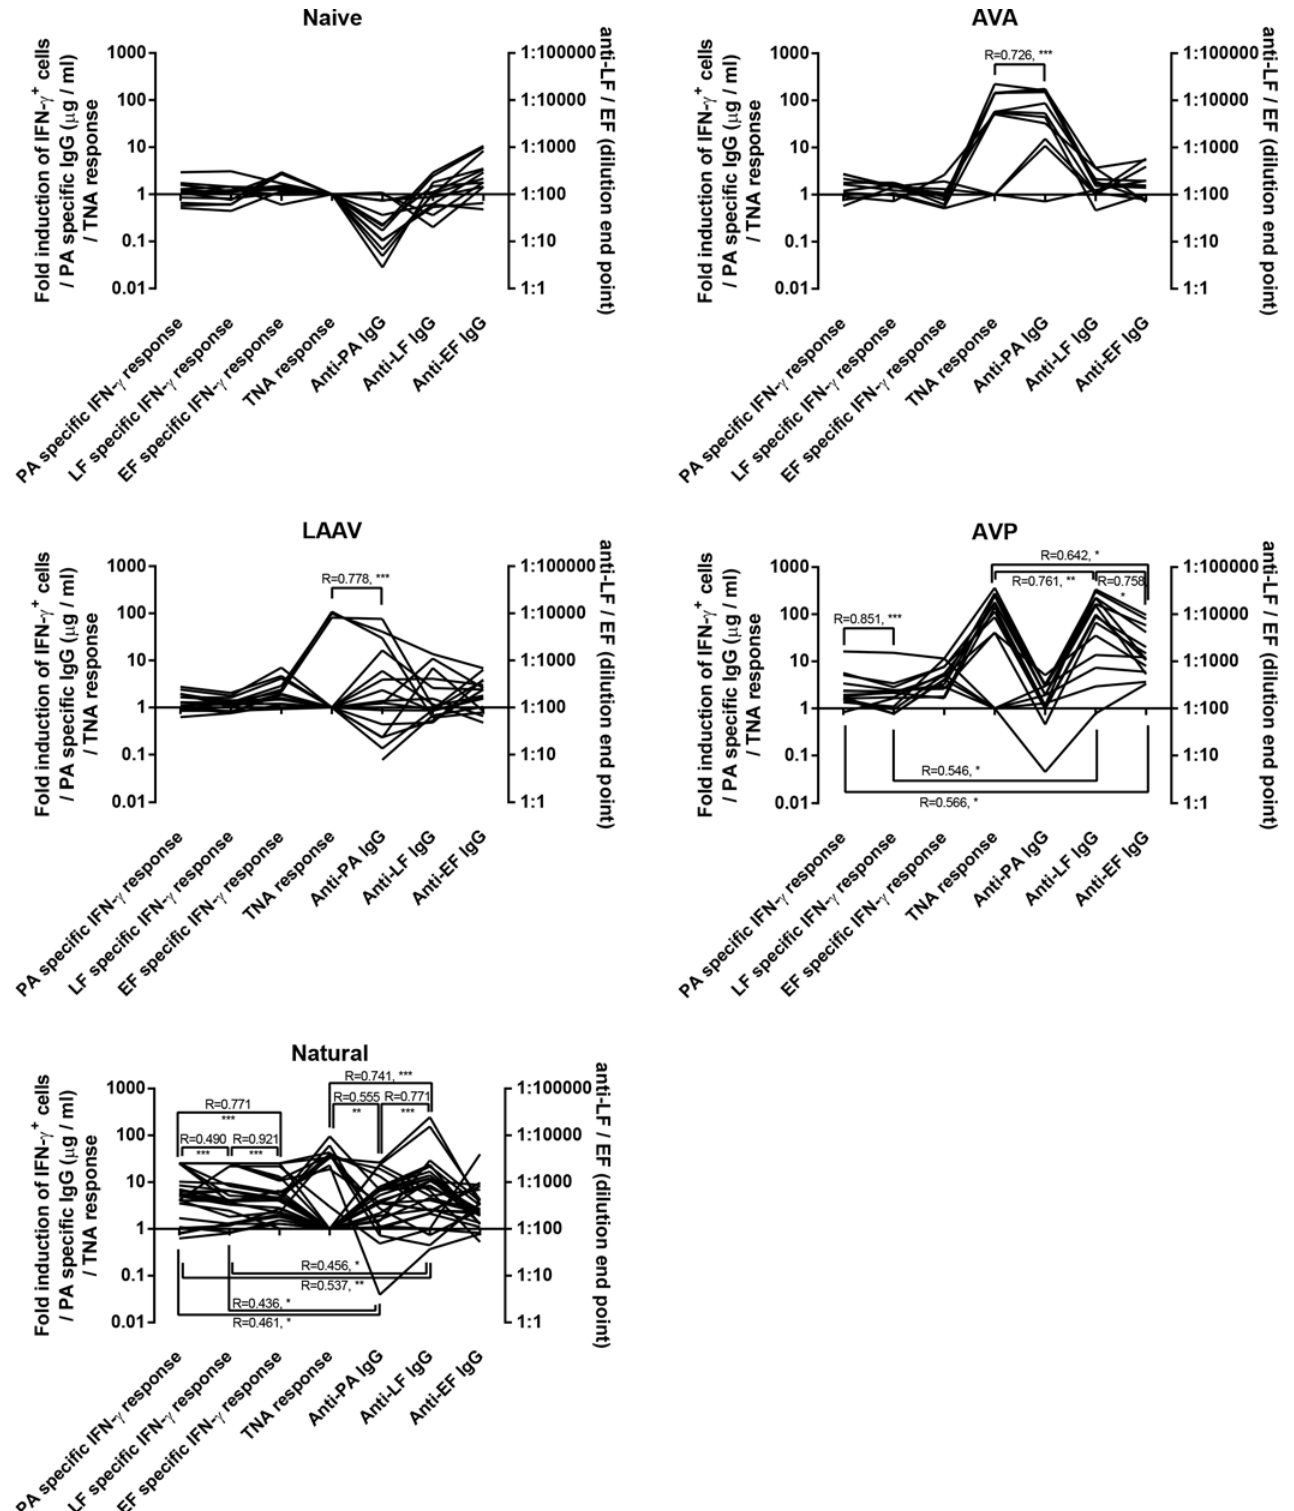
Fig 4. The relativity of different antigen specific responses in groups exposed to B . anthracis antigens in different ways. The panels show the five different groups investigated in the course of this study. Participants included individuals who had suffered from cutaneous anthrax previously, been